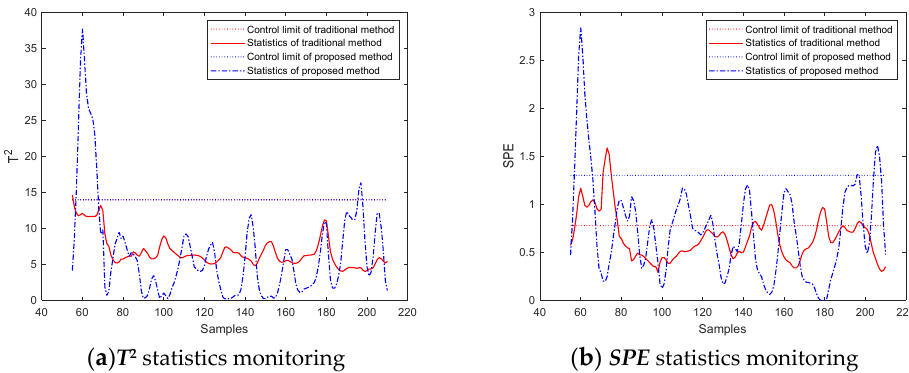
( b ) SPE statistics monitoring Figure 18. Multi-mode online monitoring of material disturbance fault.